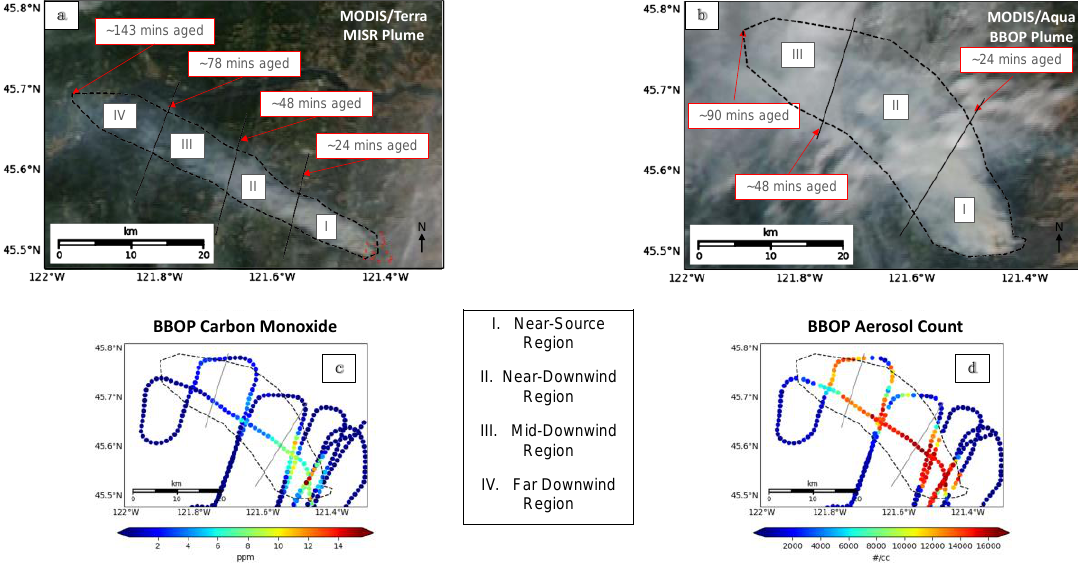
Figure 1. The Government Flats Complex Fire as seen on 21 August 2013: ( a ) at MISR overpass time (19:07 UTC; Moderate Resolution Imaging Spectroradiometer (MODIS) Terra red–green–blue (RGB) context image), and ( b ) during the Department of Energy’s Biomass Burning Observation Project (BBOP) flight operations (20:49 UTC; MODIS Aqua RGB image; the aircraft flight began at 21:20 UTC). The red dots in Panel ( a ) indicate MODIS-identified hot spots, which are used to estimate source location. The dashed lines represent the plume outlines we use for analysis. At both observation times, the plume is divided into regions (I–IV) based on estimated plume age, to allow for easy, qualitative comparison of inter- and intra-plume properties. Panels ( c ) and ( d ) represent the aircraft in situ CO and total aerosol count measurements, respectively.